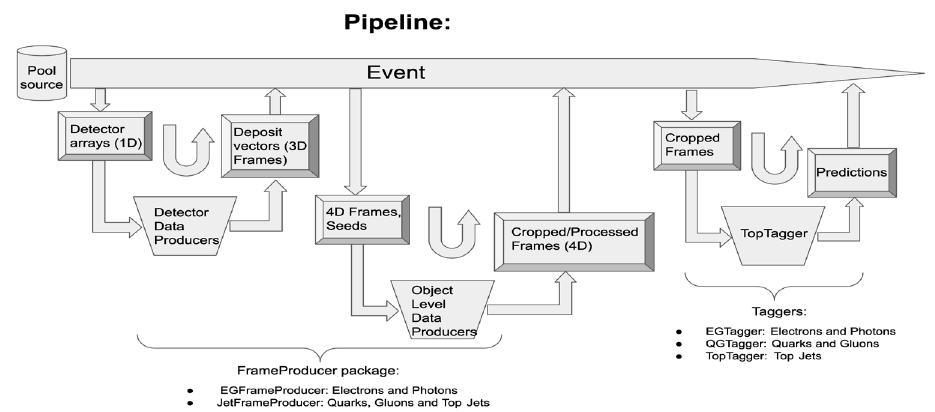
Figure 2. The end-to-end framework ( E2EFW ) pipeline as used in the tt study